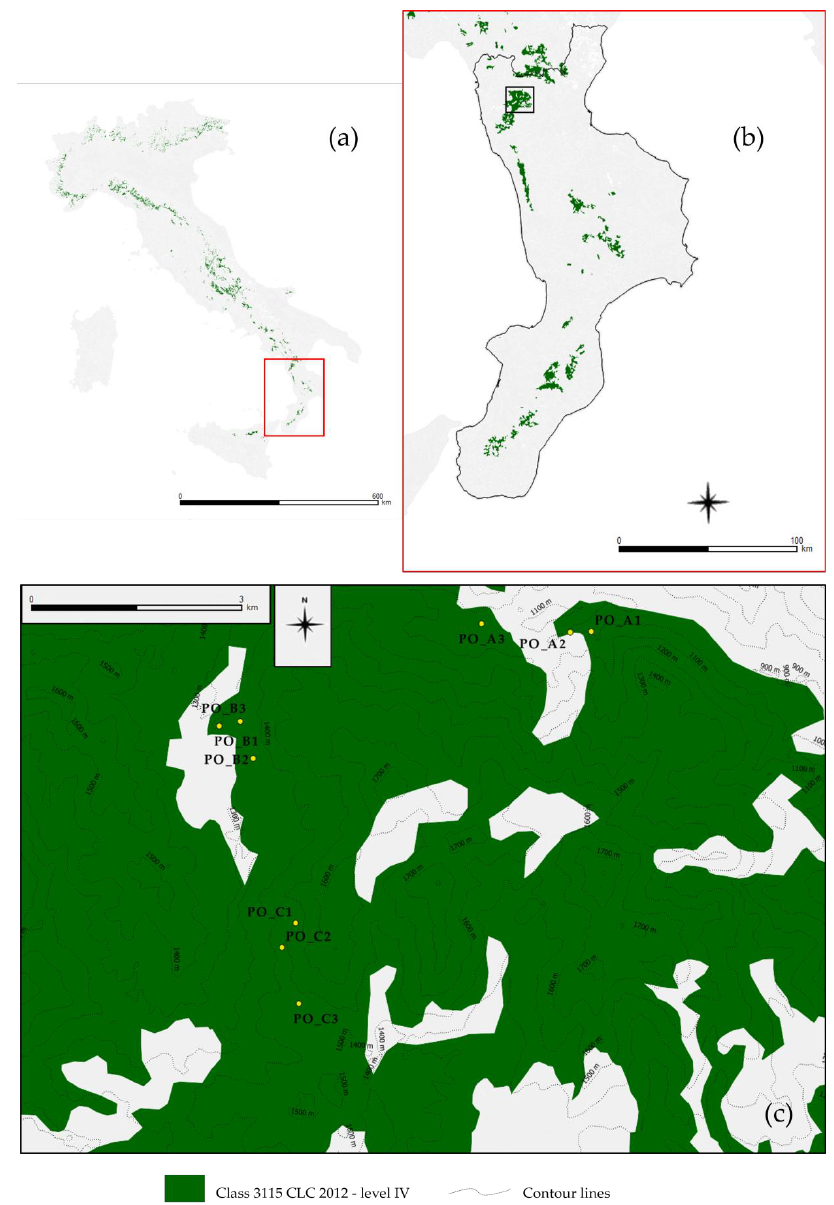
Figure 1. ( a ) Distribution of beech forests (green colored) of Italy, extracted from the Corine Land Cover (CLC) 2012 Level IV—class 3115. ( b ) Study area within the Calabria region. ( c ) Sampling stands (yellow dots) located on the Pollino Massif. Contour lines indicate elevation.